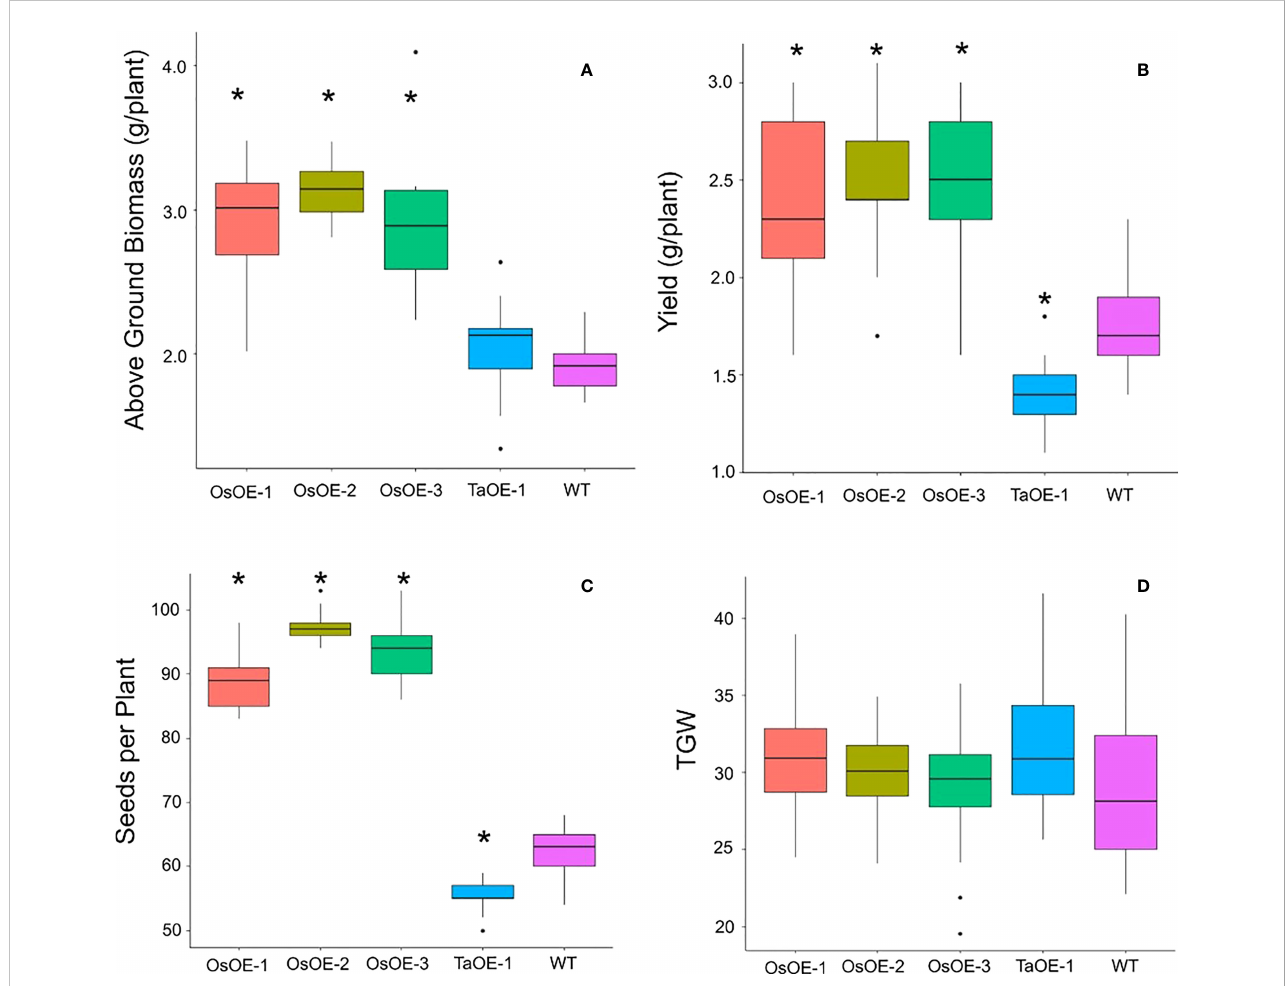
FIGURE 1 Agronomic traits of transgenic wheat plants expressing either OsPSTOL or TaPSTOL grown under low P conditions. (A) Above ground biomass (B) yield per plant (C) seeds per plant (D) thousand grain weight (TGW). A star indicates a signi fi cant difference (p val <0.05) between an overexpression line and